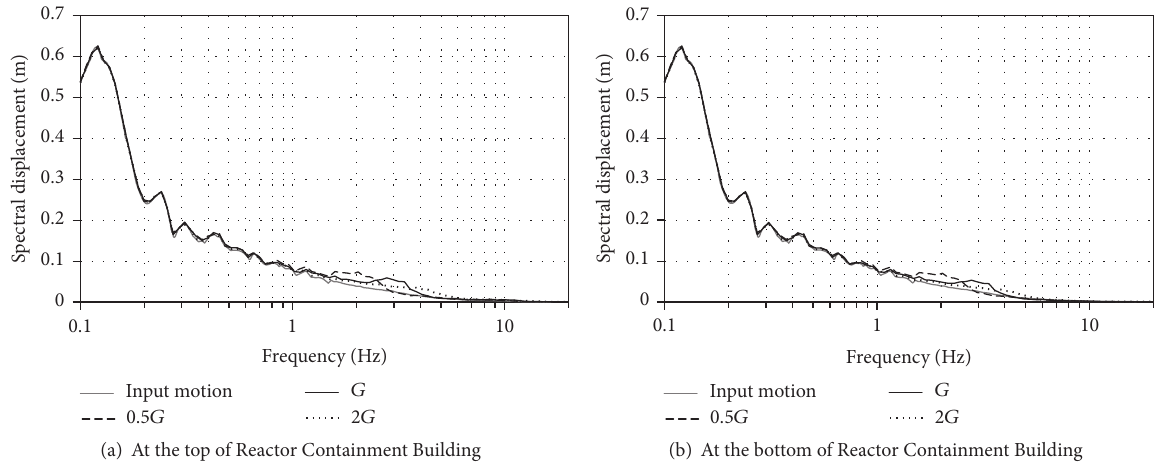
Figure 22: Comparison of response spectra displacement under vertical excitation for different soil shear